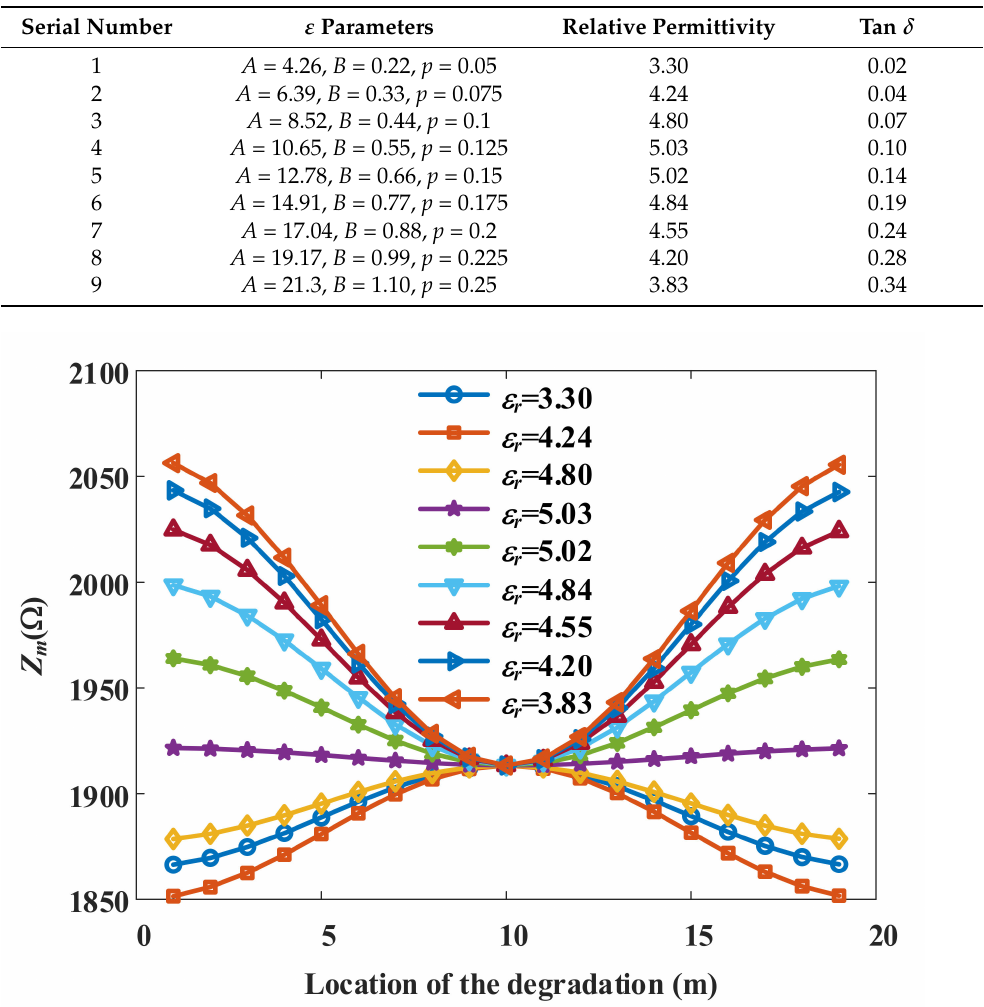
Figure 8. The relationship between the impedance magnitude at the characteristic frequency and the position of the degradation with different aging